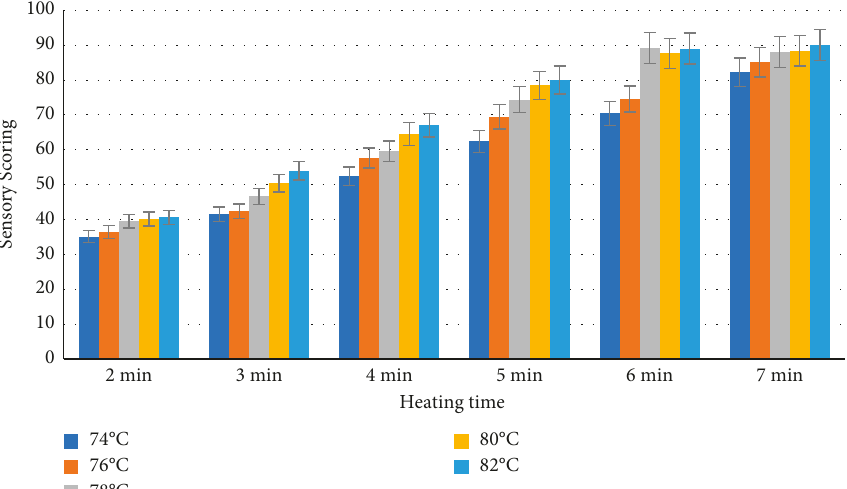
Figure 5: Variation in sensory scores of chestnut rose juice with heating time for different heating temperatures and times ( P